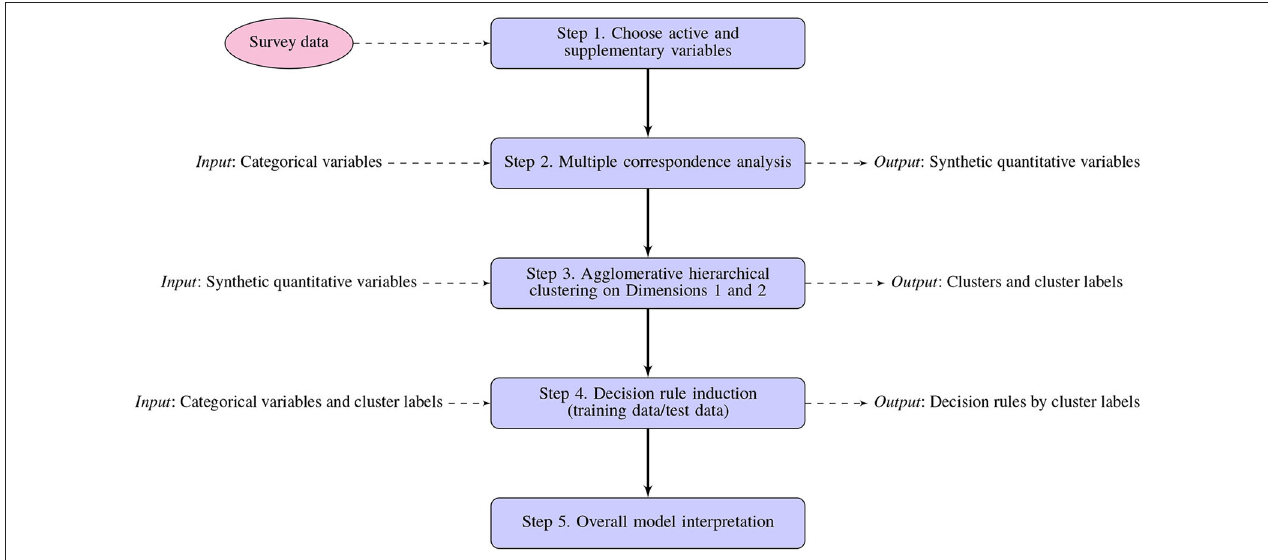
FIGURE 3 | Steps in methodological approach for exploring the relationship between protest participation and social networking sites use.